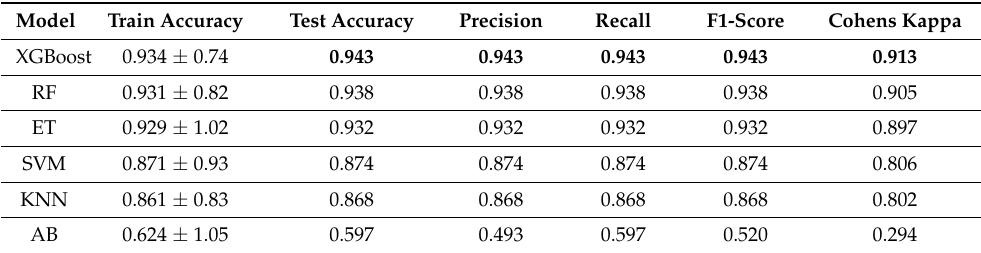
Table 4. Machine-learning model performances on training and test sets for six-class classification using all the features. The best performances are highlighted in bold.